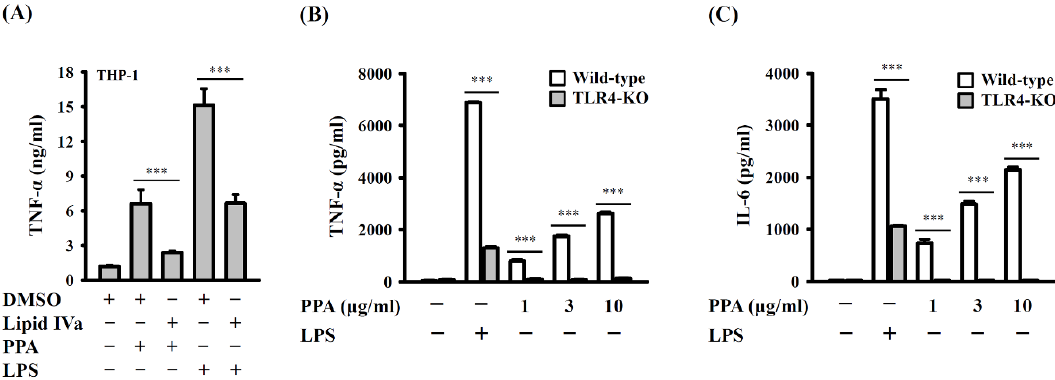
Figure 3. PPA activates macrophages through TLR4. ( A ) Effect of lipid IVa on TNF- α expression in PPA- or LPS-stimulated THP-1 macrophages. ( B ) TNF- α expression in PPA- or LPS-stimulated wild-type or TLR4 knockout BMDM. ( C ) IL-6 expression in PPA- or LPS-stimulated wild-type or TLR4 knockout BMDM. *** p < 0.001.